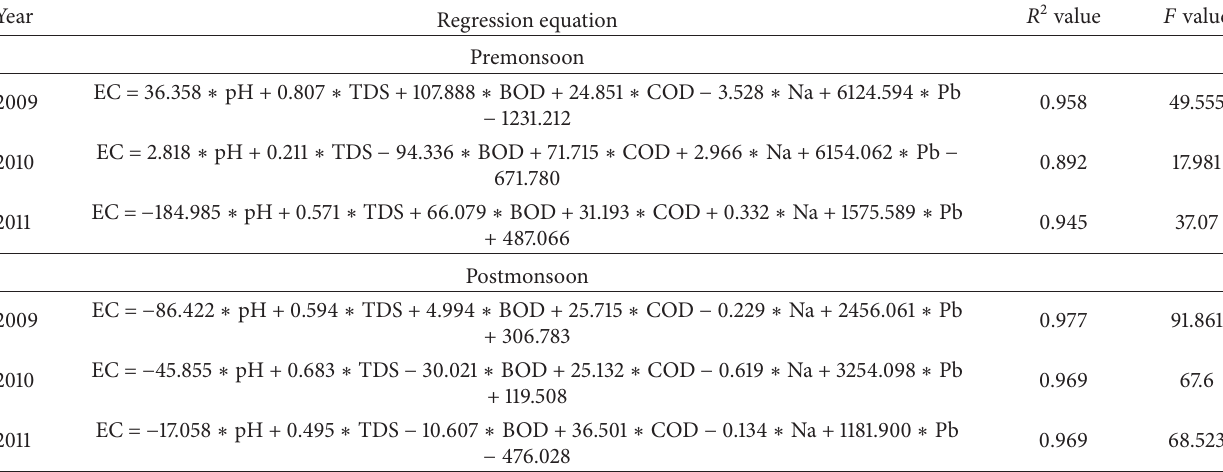
Table 9: Regression equations based on analyzed